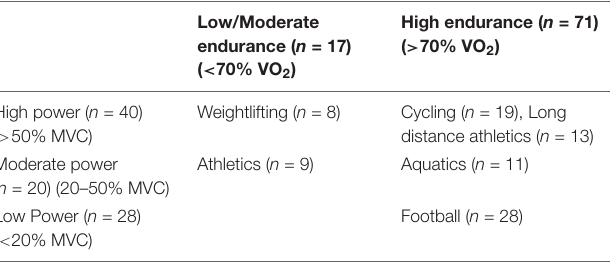
TABLE 1 | Classification of study participants into endurance groups (low/moderate and high endurance), power groups (low, moderate and high) and cardiovascular demand groups (low, moderate, and high, colored in white, light gray and dark gray shades, respectively) (Mitchell et al., 2005). Low/Moderate endurance ( n =